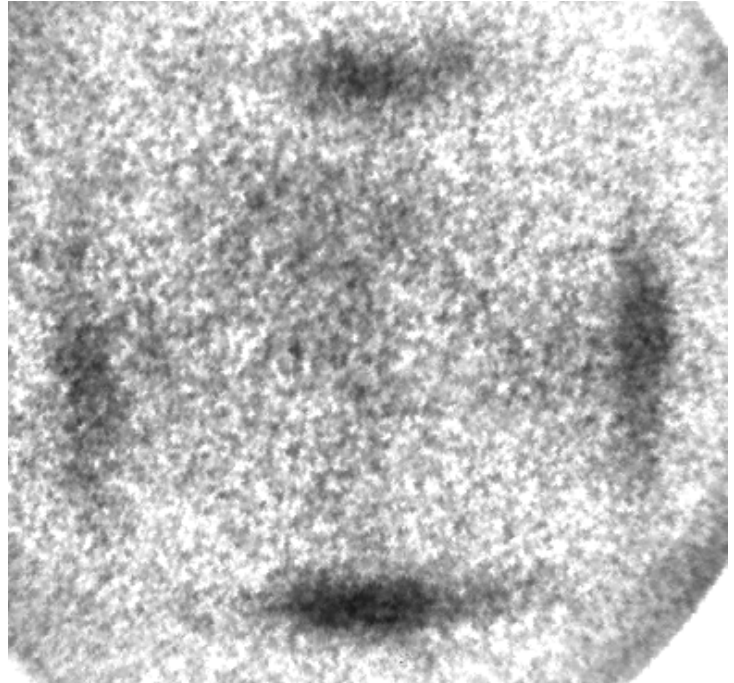
Figure 6. Equi-energy cut at Fermi level of single a-a twin domain. The non-vanishing intensity around 𝛤(cid:3365) point is apparent. The noisy nature of the image originates from an extremely small area available for